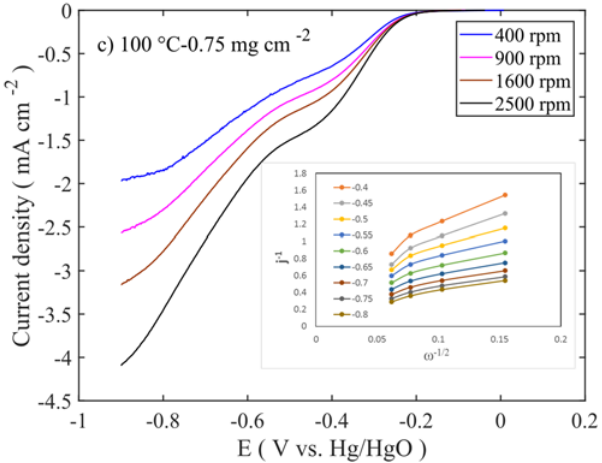
Figure 7. RDE curves of 100 °C calcined samples’ in 0.1 M KOH with 5 mV s − 1 at different rotation rates (400–2500 rpm) with three different mass loadings ( a ) 0.125, ( b ) 0.25, and ( c ) 0.75 mg cm − 2 .